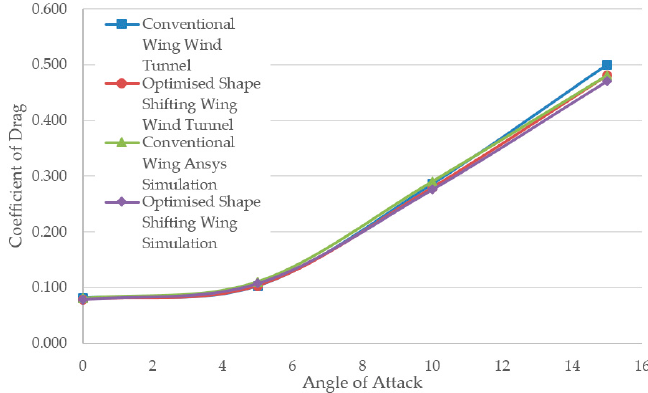
Figure 28. A graph showing coefficient of drag for wind tunnel testing and Ansys Simulation.